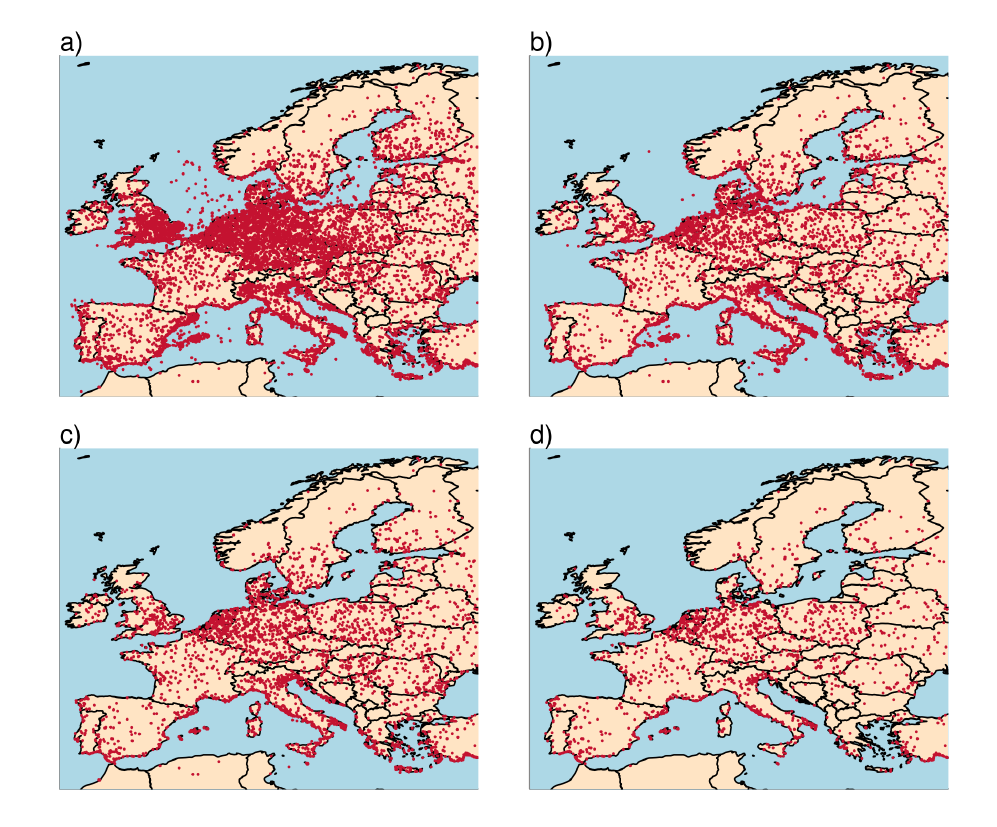
Figure 2. Locations of European Severe Weather Database (ESWD) tornado reports: ( a ) all recorded tornadoes, ( b ) tornadoes recorded in the period 2005–2019, ( c ) tornadoes recorded in the period 2005–2019 that touched land and ( d ) tornadoes recorded in the period 2005–2019 that touched land and have an intensity